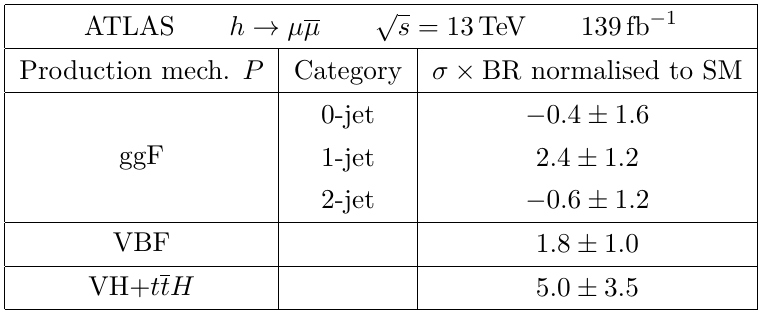
Table 4 . The Higgs signal strength parameter for h → µµ from ATLAS collaboration in ref. [68]. The production mechanisms are the ggF, the VBF, and the combination of VH and ttH ; in the first case, the categories considered are with 0 , 1 and 2 gluon associated emission.